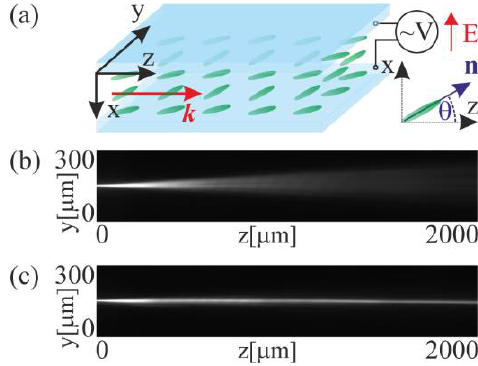
Figure 7. Experimental evidence of the light beam propagation in 6CHBT NLC cell, (λ = 1064 nm; optical power P = 1.5 mW): ( a ) The geometry of a cell and molecular orientation induced by an electric field of amplitude above the threshold value. ( b ) Diffraction observed in a yz -plane for beam propagation without biasing voltage. ( c ) Nematicons propagation for U = 1.6 V.